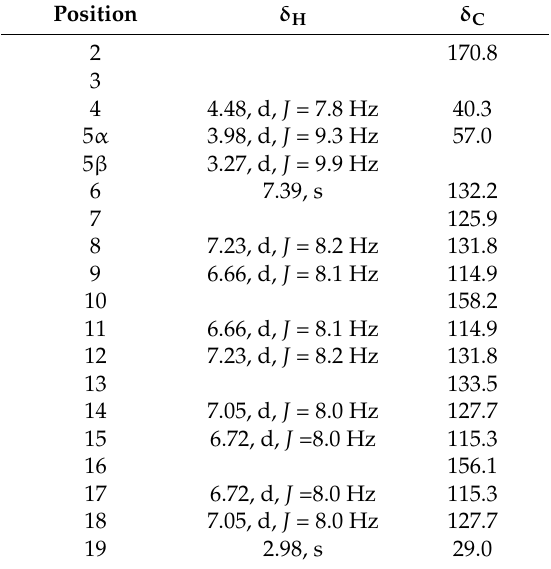
Table 1. 1 H (500 MHz) and 13 C (125 MHz) NMR data for the isolated compound in MeOD ( J in Hz).